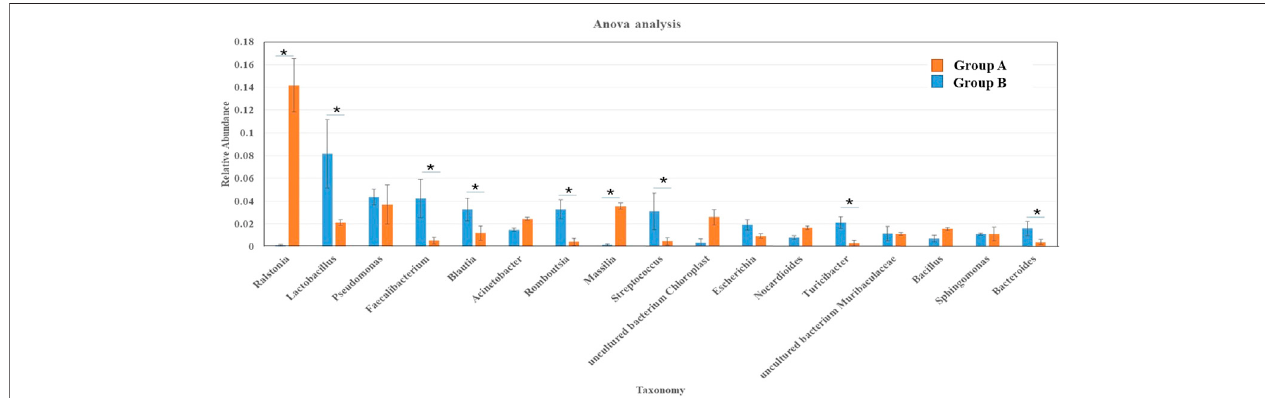
FIGURE 7 | Signi fi cant analysis of differences between sedimentary groups — analysis of variance. Note: The abscissa represents species (showing the top 20 species with the average relative abundance greater than 1%), the ordinate represents the relative abundance of species, the columns with different colors represent each sample, and * on the column indicates signi fi cant difference ( p <